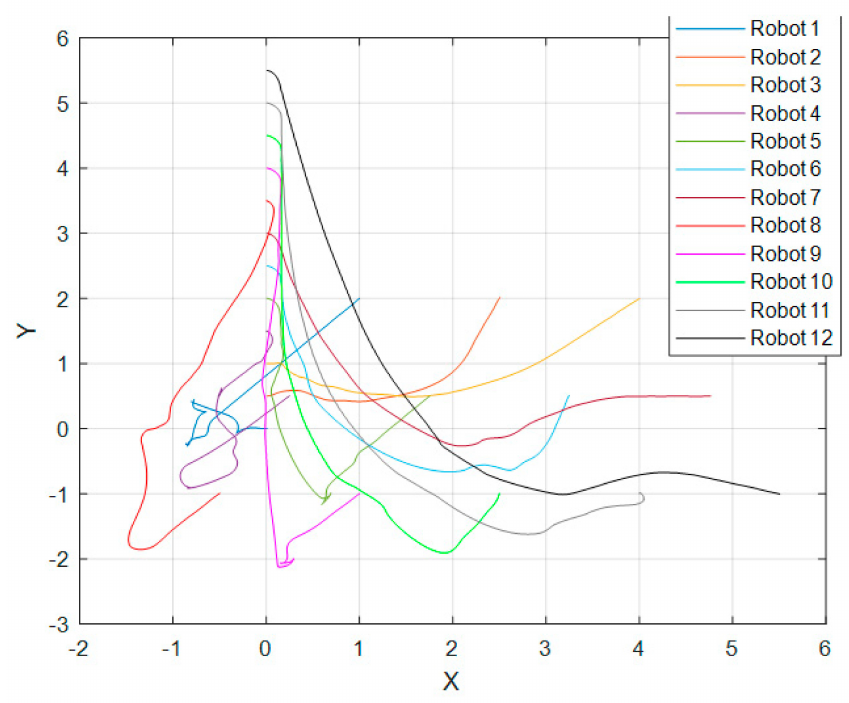
Figure 13. Trajectories in the 12-robot simulation. The values of x hi , y hi , v i , and ω i are plotted in Figures 14 and